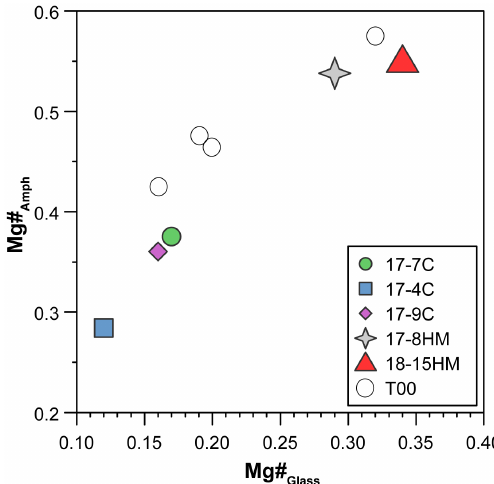
Figure 5. Positive correlation between Mg# of amphiboles and glasses suggesting conditions close to equilibrium. T00: data from Tiepolo et al. (2000).